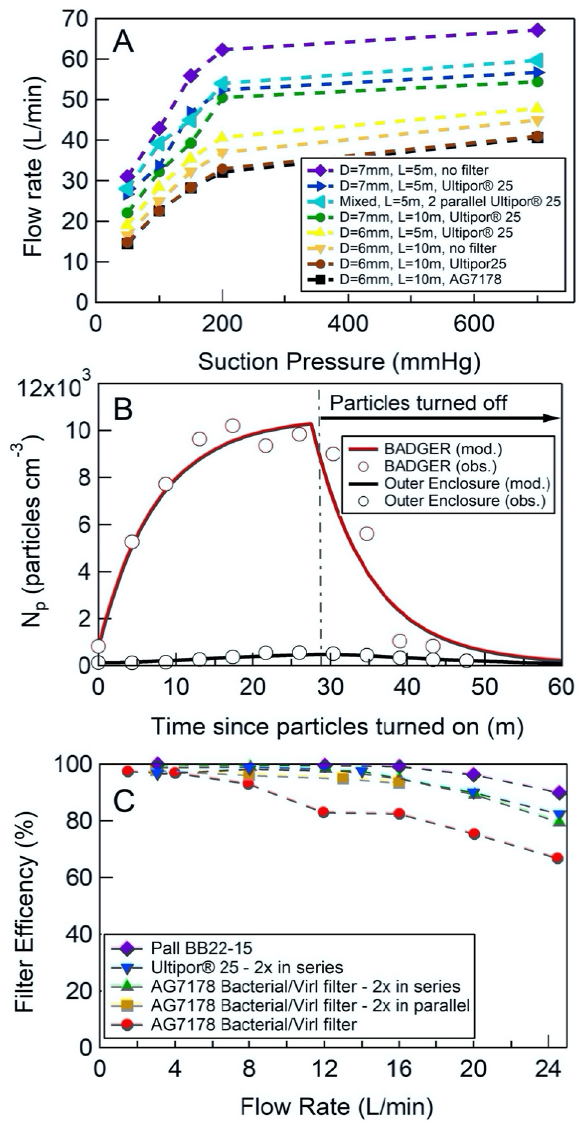
Figure 6. Measurement of air flow and results of aerosol particle containment test. ( a ) Air flow rates from a hospital room’s in-wall vacuum suction source at various suction pressures, tubing inner diameters (D), tubing length (L), and viral filters (Ultipor 25 or AG7178). Mixed setup: 2 Ultipor 25 filters connected in parallel to 1.8 m of a dual-limb breathing circuit tubing (Adult UltraFlex Dual-Limb breathing circuit) and 3.2 m of 7 mm inner diameter tubing. ( b ) Particle containment result at outflow rate of 13 L/min. Sub-micrometer particle concentrations were measured in both the BADGER (red circles) and the exterior enclosure (black